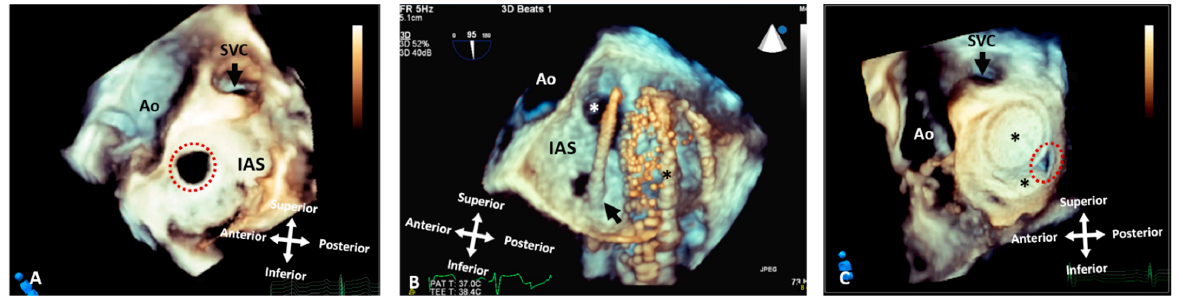
Figure 6. Three-dimensional rendered images from TOE demonstrating the appearance of defects within the atrial septum. All images are shown in anatomic orientation from the left atrial view. ( A ) Demonstrates a secundum ASD as outlined by the dashed line, which appears ideal for closure with a percutaneous device. ( B ) This image illustrates careful intra-procedure imaging depicting a septum with multiple defects. Live 3D can be very informative in allowing visualization of catheters (arrow), multiple defects (white asterisk) and balloons used to interrogate the defect size and septal tissue (black asterisk). ( C ) Two ASD occlusion devices (asterisk) used to close multiple defects, with a small residual defect noted posteriorly (dashed line). Ao: Aorta; IAS: Interatrial septum; LA: Left atrium; RA: Right atrium; RLPV: Right lower pulmonary vein; RUPV: Right upper pulmonary vein and SVC: Superior vena cava.